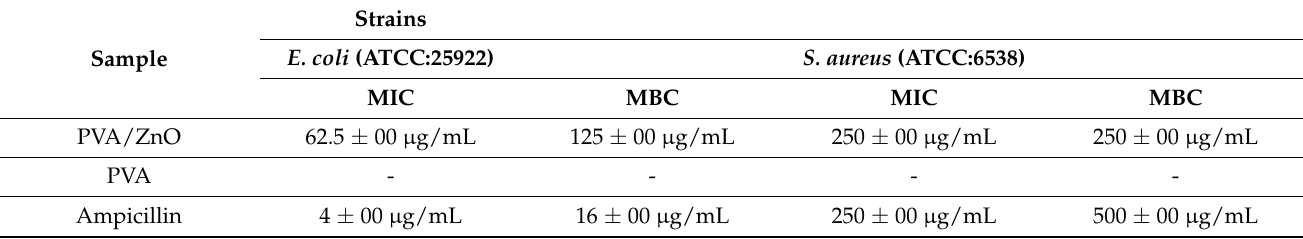
Table 3. MIC and MBC of the PVA and PVA/ZnO composite nanofibers [103].